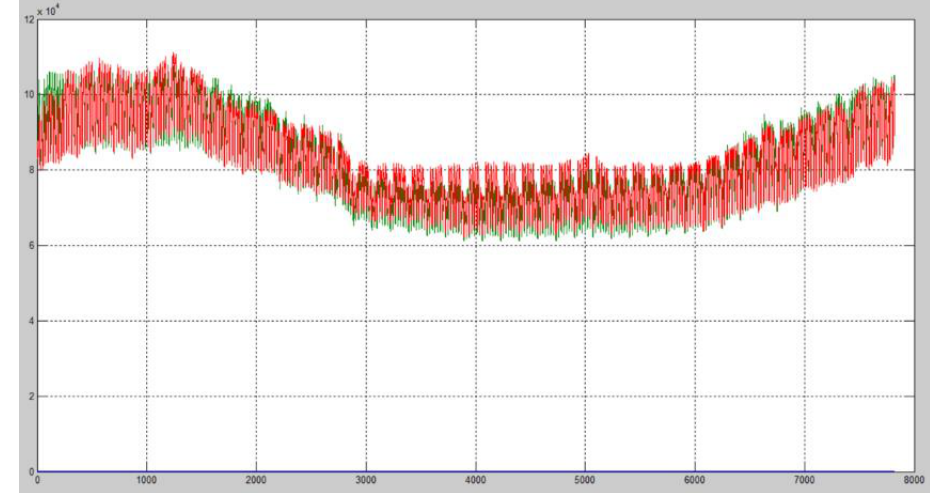
Figure 6. Forecasting results window.